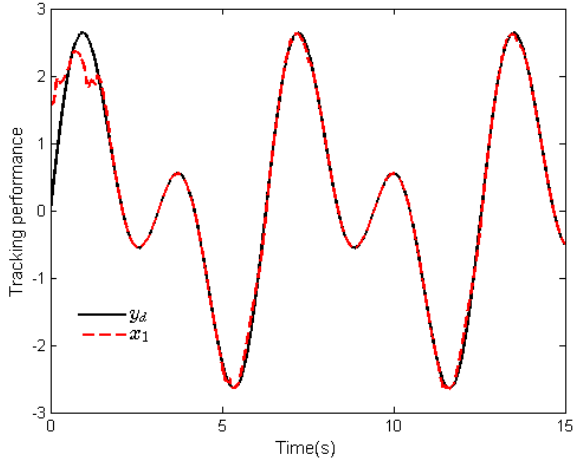
Figure 5. The curves of system output x 1 and reference signal y d